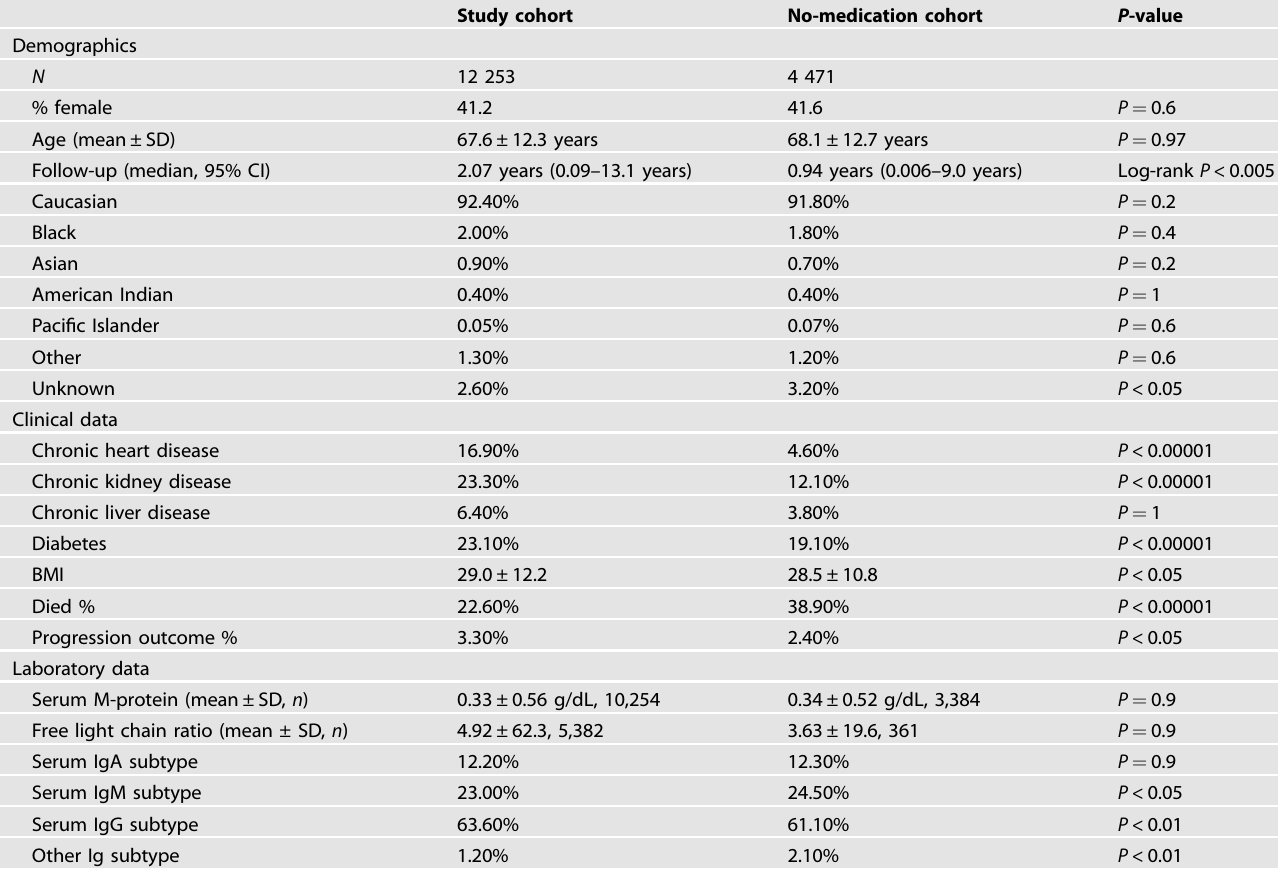
Table 1. Study cohort and no-medication cohort